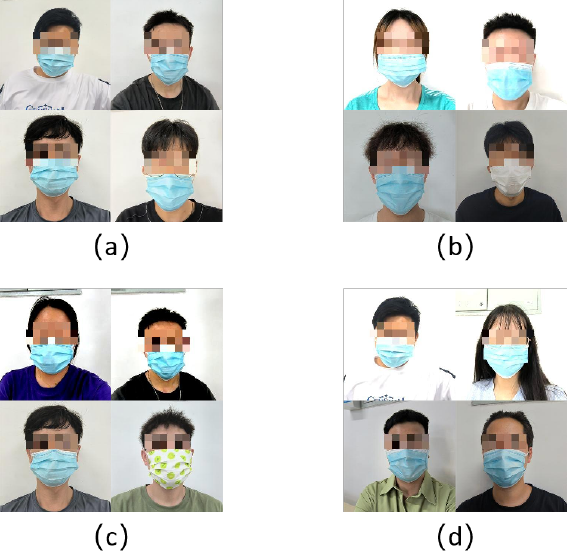
Figure 6. Test data set. ( a ) Unprocessed face images. ( b ) Face images with brightness adjustment. ( c ) Contrast-adjusted face images. ( d ) Face image with simultaneous contrast adjustment and bright- ness